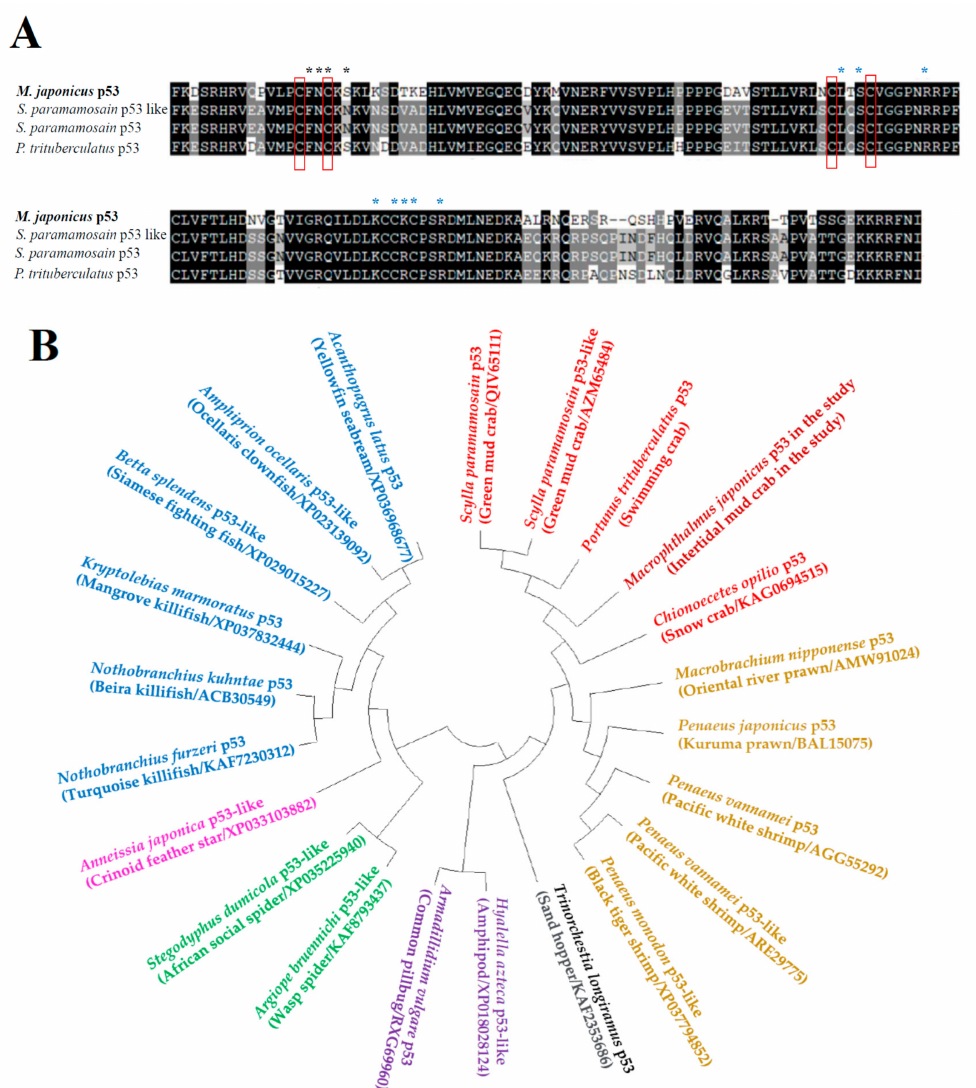
Figure 1. Characterization of Macrophthalmus japonicus p53 gene. ( A ) ClustalW multiple-sequence alignment of the deduced Mjp53 gene sequence with homologous p53 genes of various crabs. Shaded marks in black indicated completely conserved residues in all species. Dimerization site (polypeptide- binding site) and zinc-binding site (ion-binding site) are indicated by black asterisk mark and blue asterisk mark, respectively. DNA-binding site (nucleic-acid-binding site) is presented as a red rectangular box. ( B ) Phylogenetic circle tree of Mjp53 gene with other p53s . Neighbor-joining analysis showed a circle tree for phylogenetic relationships in p53 amino acid sequences using the MEGA